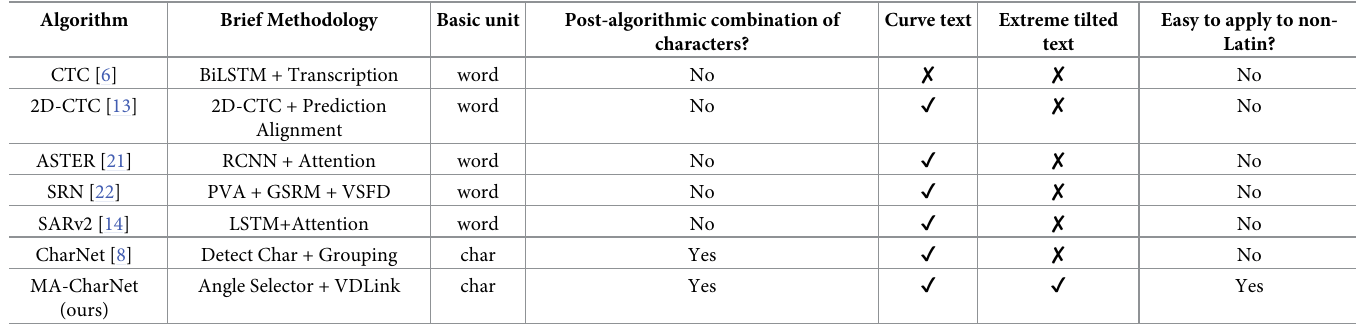
Table 1. Comparison of some representative text recognition